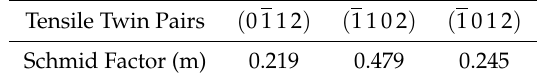
Table 2. Schmid factors of each of the three distinct { 1012 } pairs with [ 101 30 ] loading. Tensile Twin